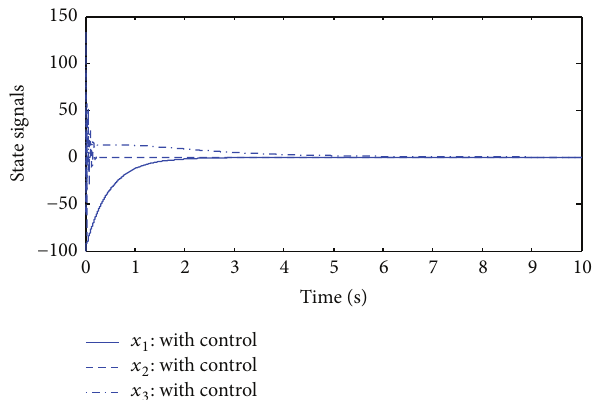
Figure 3: Transient response of state signals: closed loop system with 𝑥 0 = [−100 100 100]